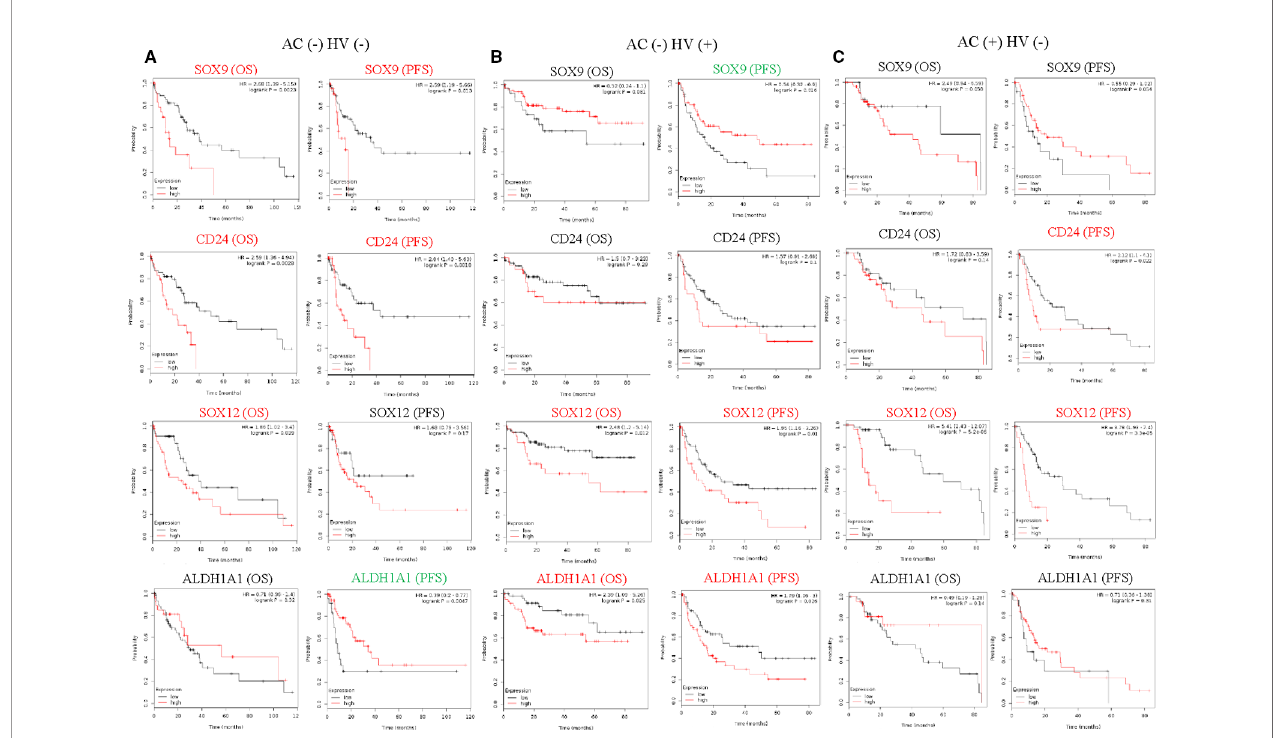
FIGURE 3 | Association of HCSC markers expression levels with prognosis of HCC with risk factors. (A) Correlation of HCSC markers high expression levels with OS (n = 91) and PFS (n = 91) of HCC without alcohol consumption (AC) and hepatitis virus (HV), (B) correlation of HCSC markers high expression levels with OS (n = 111) and PFS (n = 114) of HCC with HV, (C) correlation of HCSC markers high expression levels with OS (n = 76) and PFS (n = 78) of HCC with AC, red font means negative correlation, green font means positive correlation, black font means no